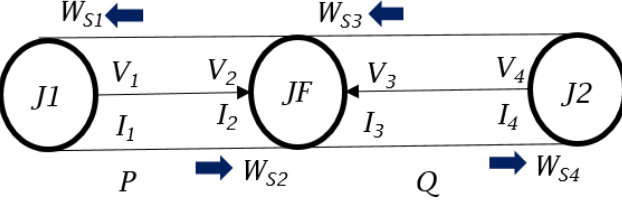
Figure 3. Fault emulation by the BLT